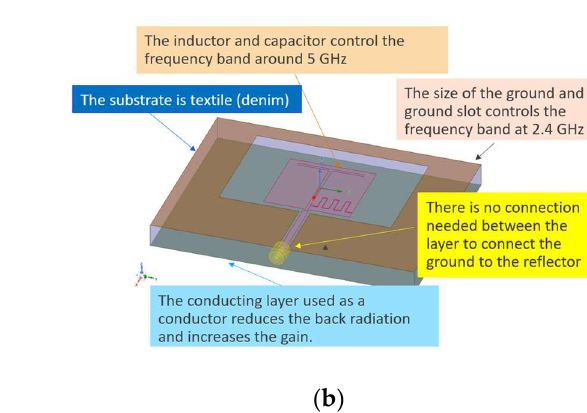
Figure 1. Proposed dual band antenna structure: ( a ) Top view of the antenna, all dimensions are given in mm; ( b ) Major features of the design.